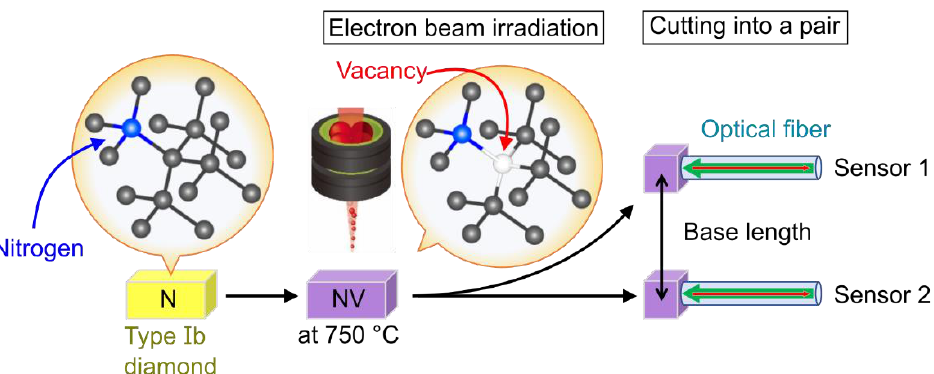
Figure 3. Fabrication process of the NV centers in diamond using electron beam irradiation. A type Ib diamond after electron beam irradiation is divided into two and attached to each optical fiber.